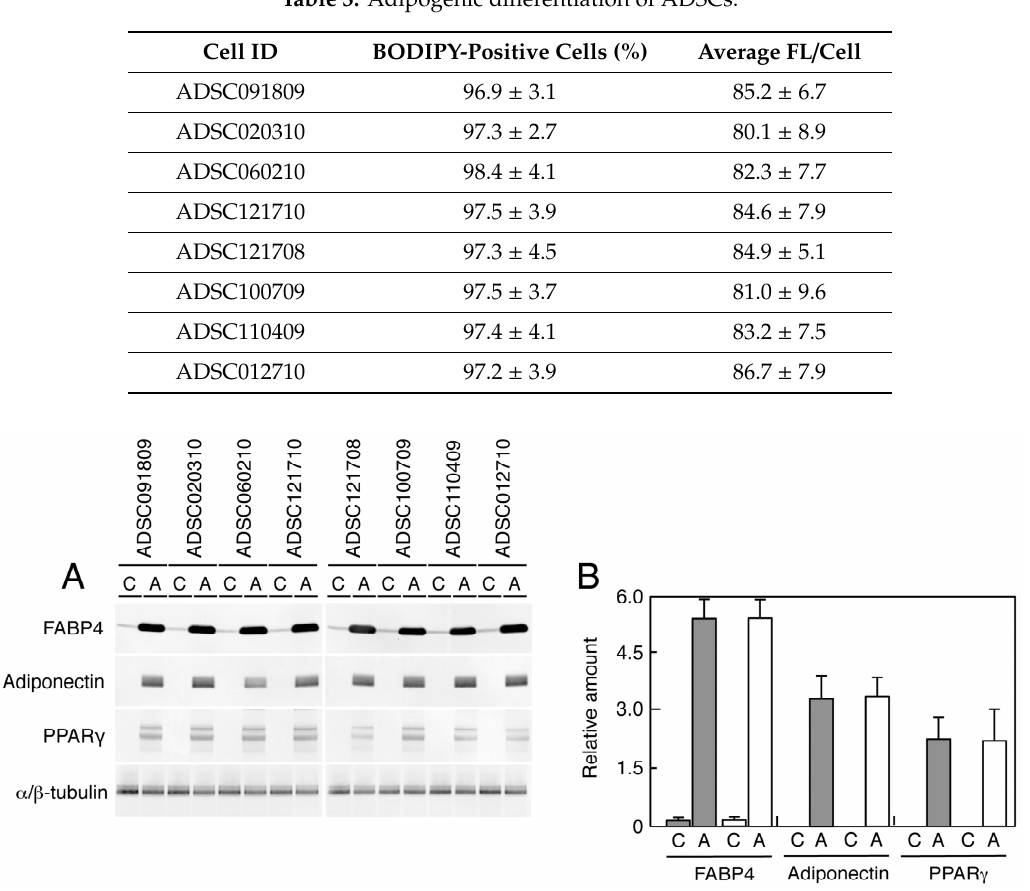
Figure 2. Adipogenic differentiation of ADSCs in culture. ADSCs were stained with 10 µg/mL BODIPY 493/503 and counterstained with 0.1 µg/mL of DAPI. Magnification ×100; the scale bar indicates 100 µm. Table 3. Adipogenic differentiation of ADSCs.